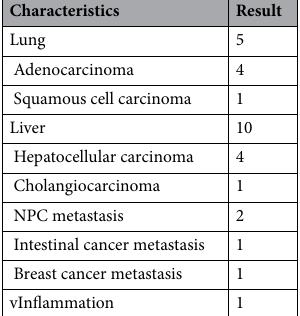
Table 3. Biopsy pathology result of nodules. NPC, nasopharyngeal carcinoma.